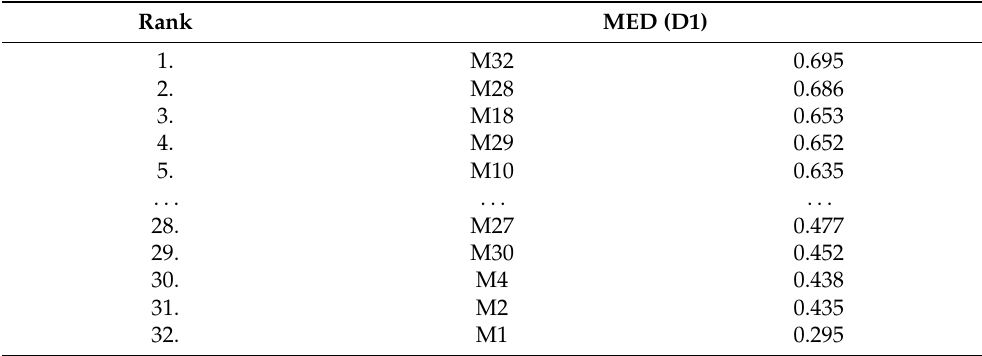
entire monitored